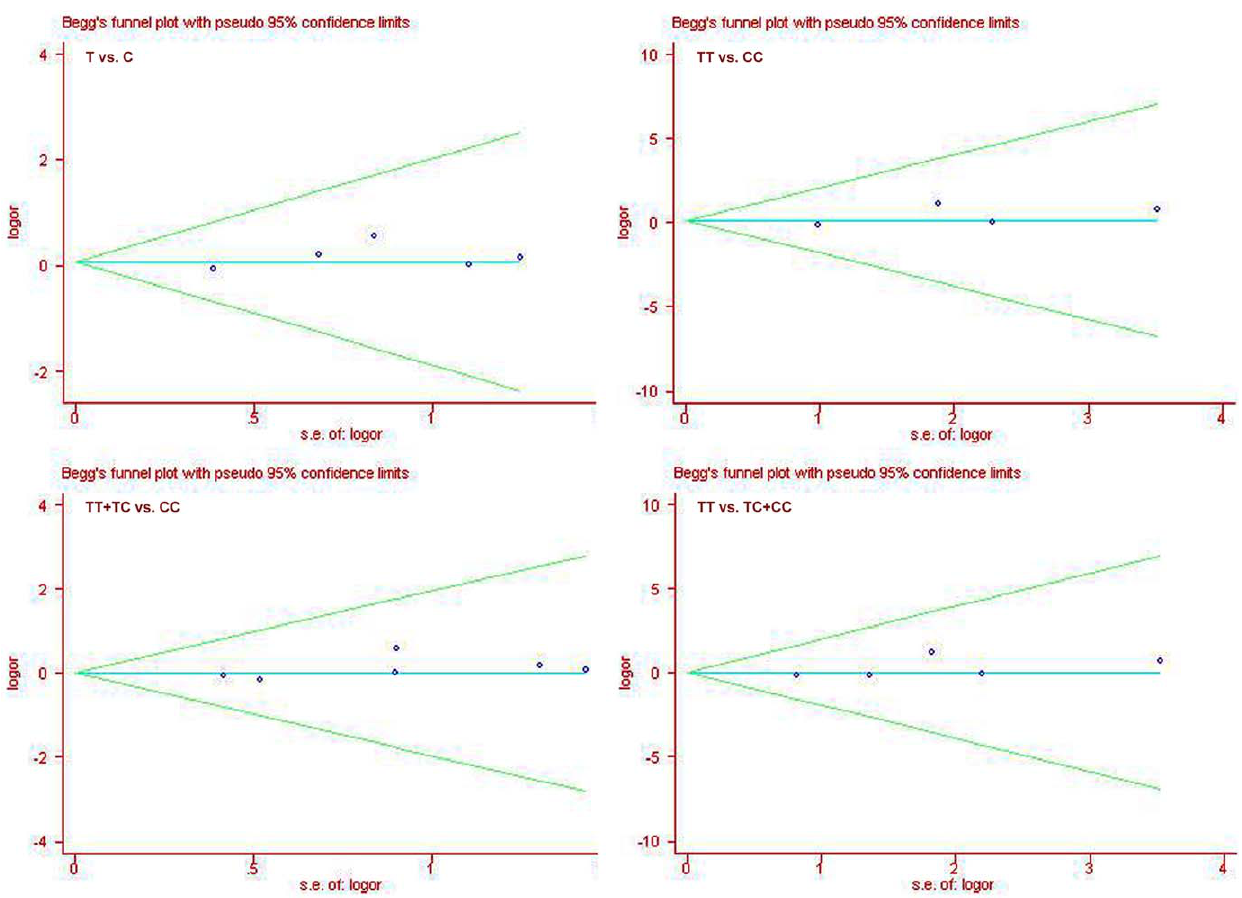
Figure 3. Funnel plots for overall studies. The shapes of the funnel plots did not reveal any evidence of obvious asymmetry visually. se: standard error; OR: odds